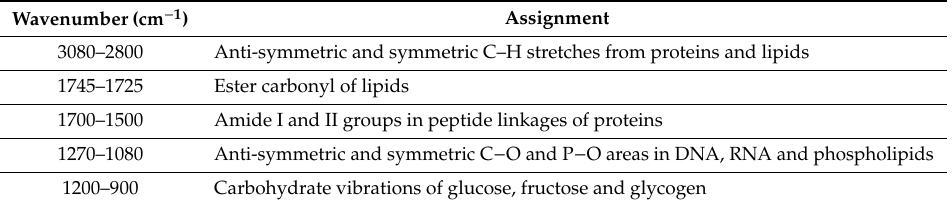
Table 1. Assignment of typical absorption bands observed in biological IR